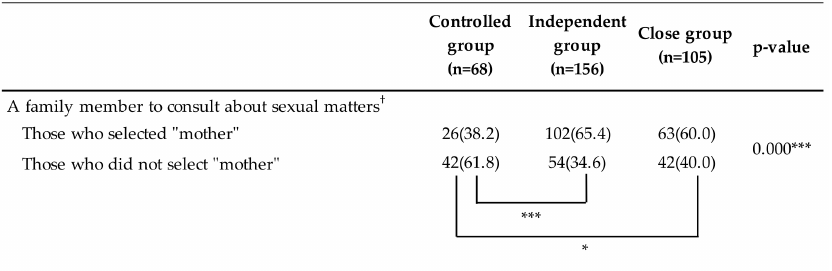
Figure 2. Mother-daughter relationship clusters and percentage of those who indicated their “mother as a consultant” in each cluster ( n = 329). † Options: mother, father, brother, sister, and other. Fisher’s exact test and multiple comparison test (Bonferroni correction). The number is the number of respondents, and the value in ( ) is the %. *** p < 0.001, * p < 0.05.